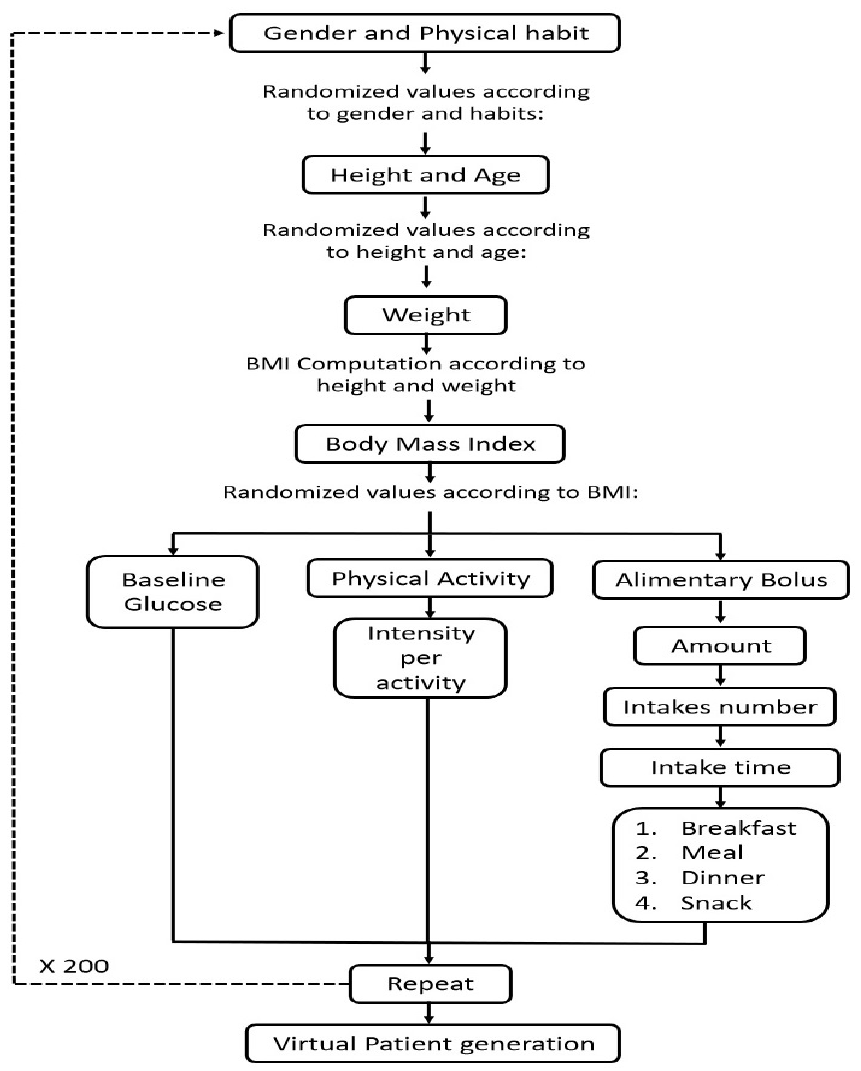
Figure 3. Generation of the virtual population. Methodology developed for the generation of 200 virtual patients with 100 of them having sedentary habits and the rest having regular physical